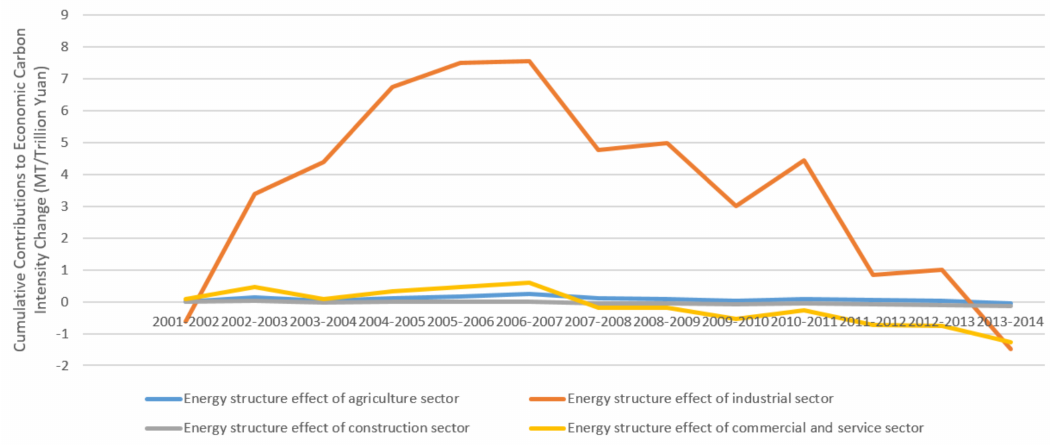
Figure 8. Cumulative Contributions of Various Sectors’ Energy Structure to the Economic Carbon Intensity